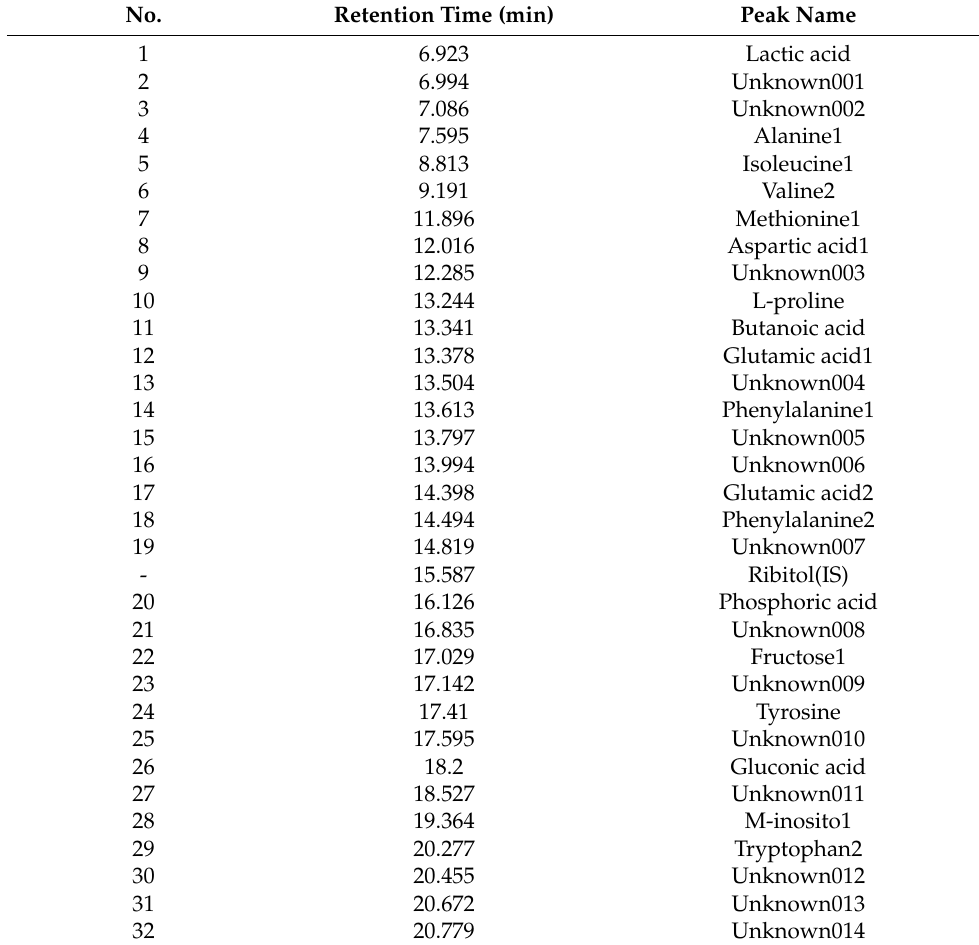
Table 1. Substances detected by GC-FID.